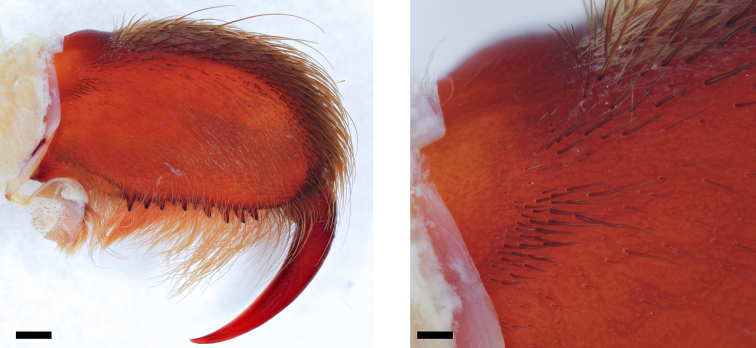
Cheliceral strikers of TapinaucheniusviolaceusA overview B detailed view. Scale bars: 20 µm (A); 100 µm (B).